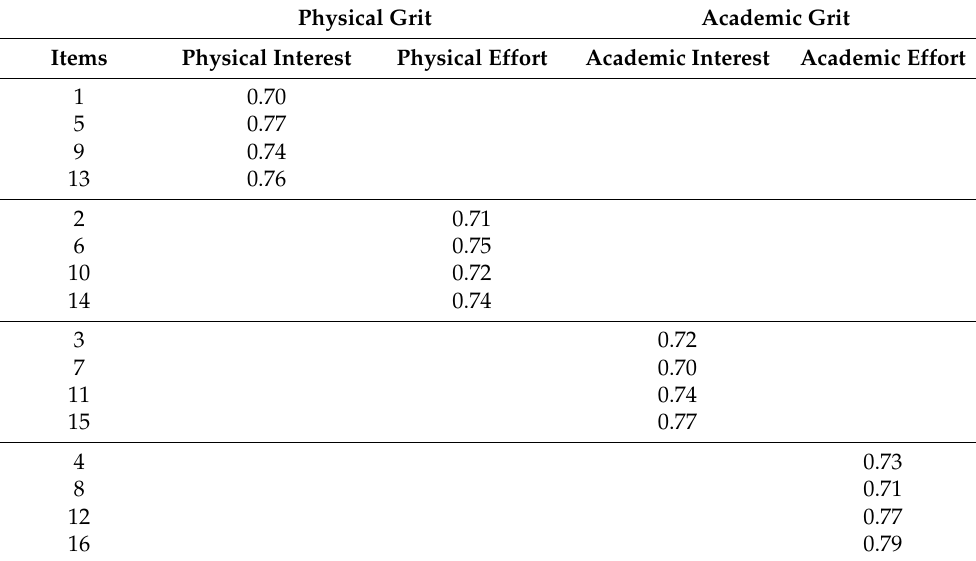
Table 1. Exploratory Factor Analysis.